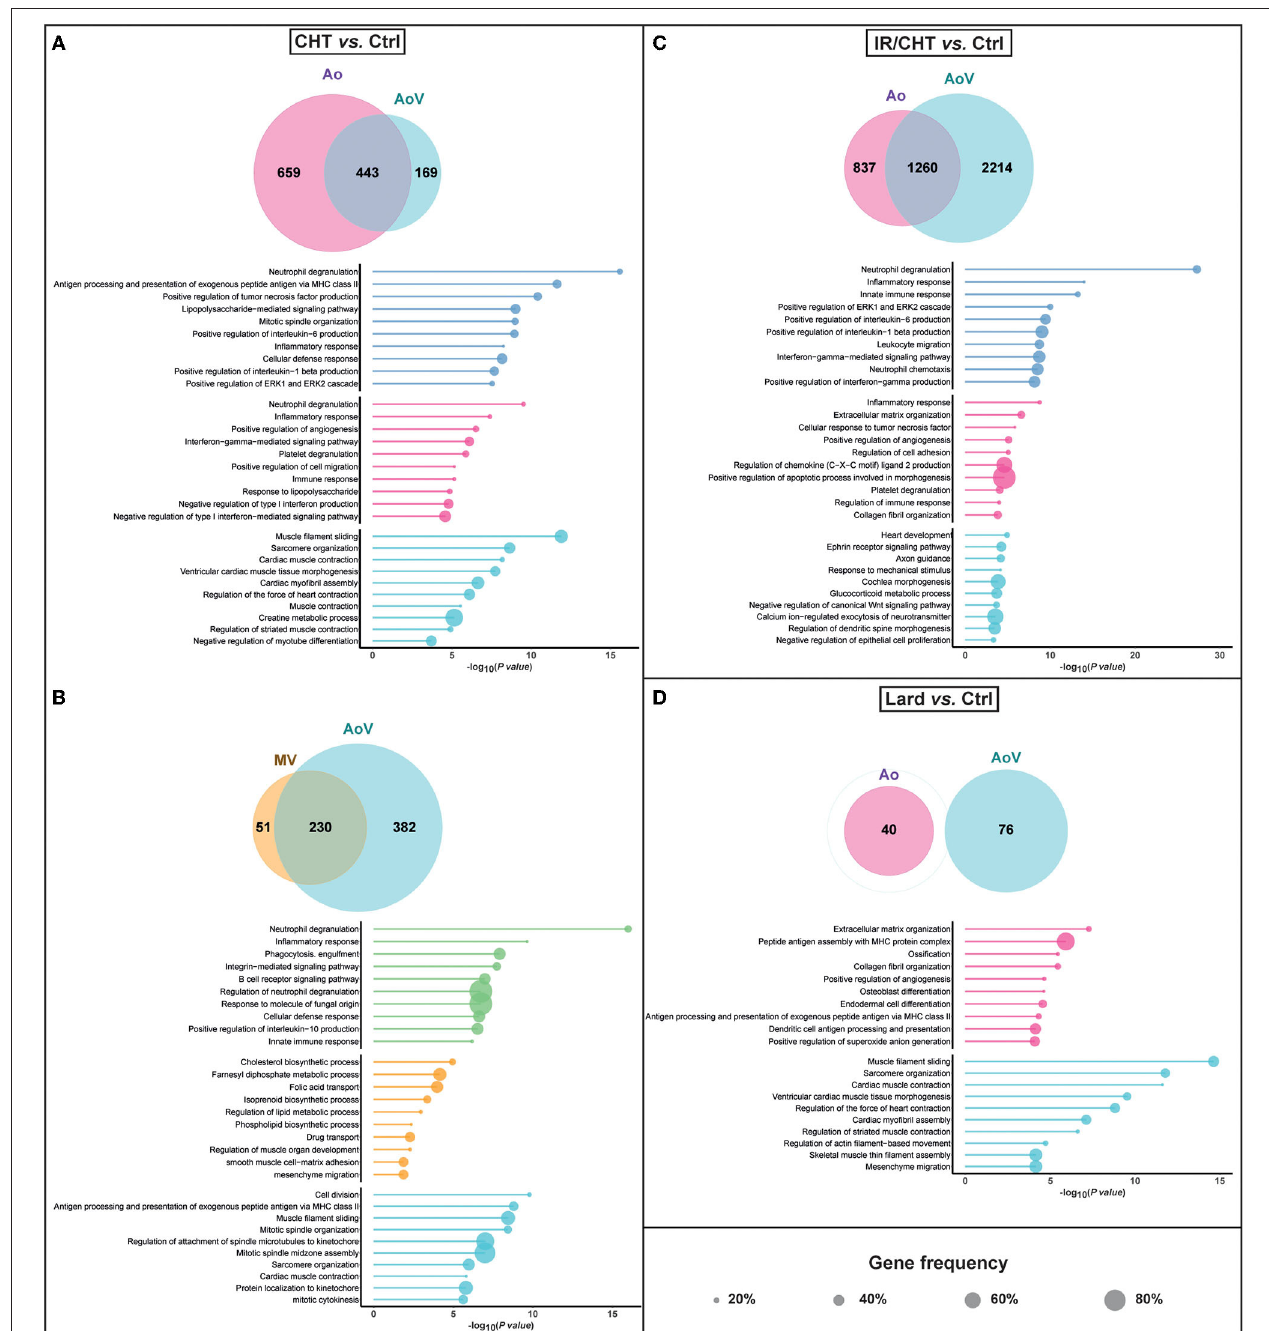
FIGURE 5 | RNA sequencing (RNAseq) analysis of differentially expressed genes (DEGs) in the aorta, the aortic valve, and the mitral valve induced by cholesterol-enriched diet (CHT), alone or combined with irradiation (IR/CHT), and lard-enriched diet as compared to chow diet (Ctrl) (Ctrl, n = 7; CHT, n = 6; Lard, n = 7; IR/CHT, n = 7). Venn diagrams represent numbers of specific and common DEGs between tissue pairs for each comparison. Lollipop plots of gene ontology (GO) terms depict the top 10 biological processes affected by specific and common DEGs, with corresponding gene frequency and -log 10 ( P -value) (Wald test in DESeq2 package). Detailed statistical methods are provided in the Methods section. (A) Comparison of DEGs and affected biological processes in the aorta and aortic valve following 16-week treatment with a cholesterol-rich diet. (B) Comparison of DEGs and affected biological processes in the aortic and mitral valves following 16-week treatment with a cholesterol-rich diet. (C) Comparison of DEGs and affected biological processes in the aorta and aortic valve following 16-week treatment with a cholesterol-rich diet combined with irradiation. (D) Comparison of DEGs and affected biological processes in the aorta and the aortic valve following 16-week treatment with a lard-rich diet. Ao, aorta; AoV, aortic valve; MV, mitral valve.